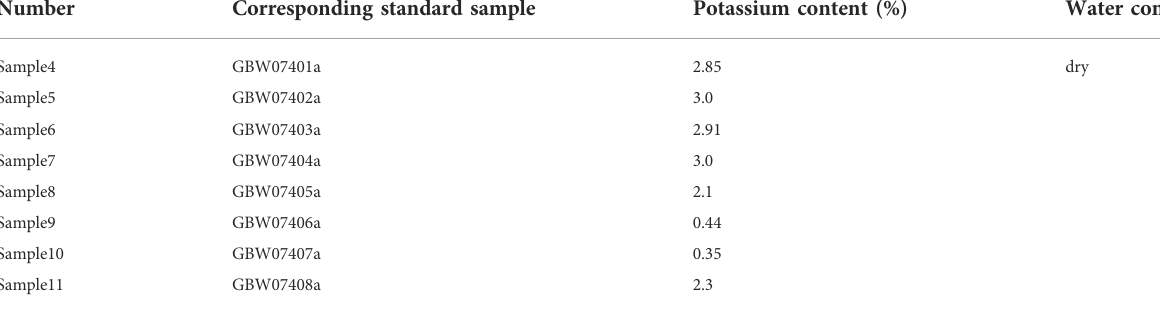
TABLE 3 Relevant characteristics of the second group of tablet samples.